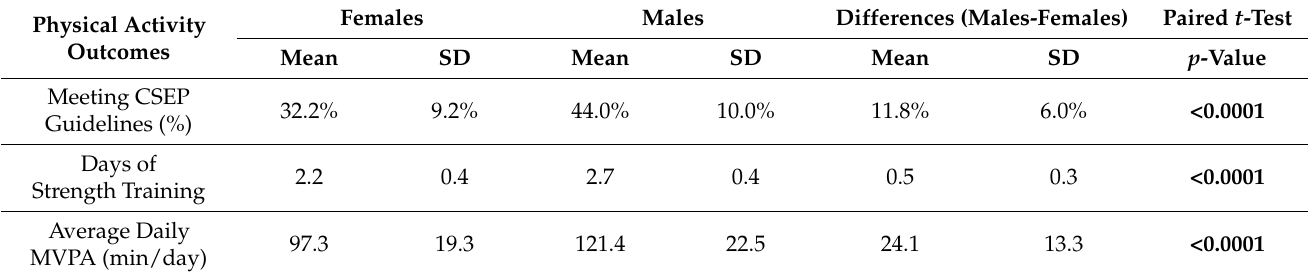
Table 1. School-Level Physical Activity Outcomes of Male and Female Students from Year 7 (2018–2019) of the COMPASS